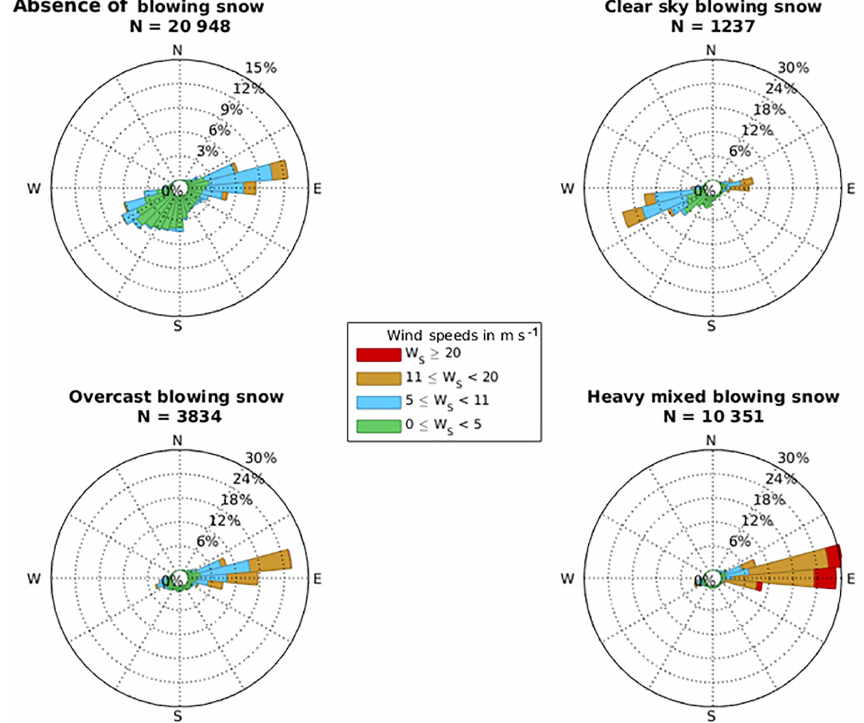
Figure 10. Wind roses presenting the wind direction for the absence blowing snow ( N = 22903), blowing snow with ( N = 948) or without precipitation ( N = 1032), and heavy mixed blowing snow ( N = 1490) at PE station